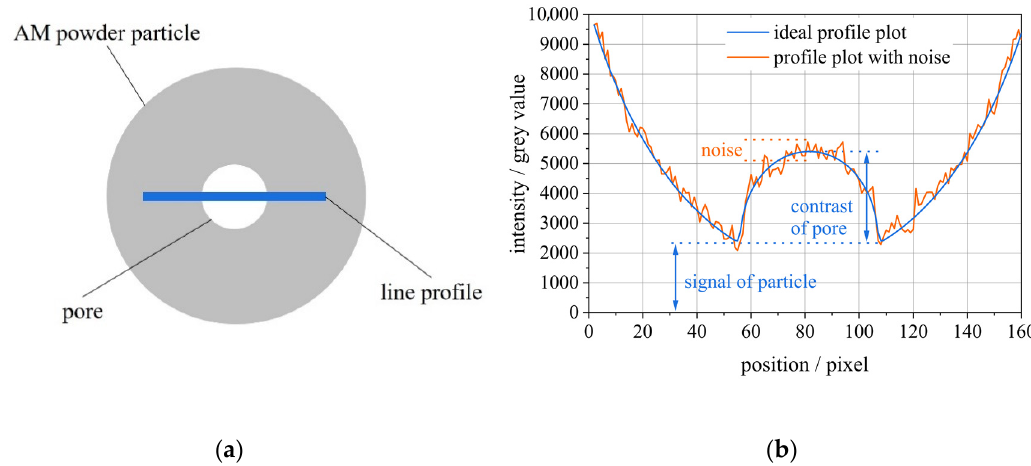
Figure 1. Scheme for measuring the contrast to noise ratio (CNR): the position of the line profile for the CNR measurement ( a ) and representation of the corresponding profile with and without noise to measure the CNR ( b ).